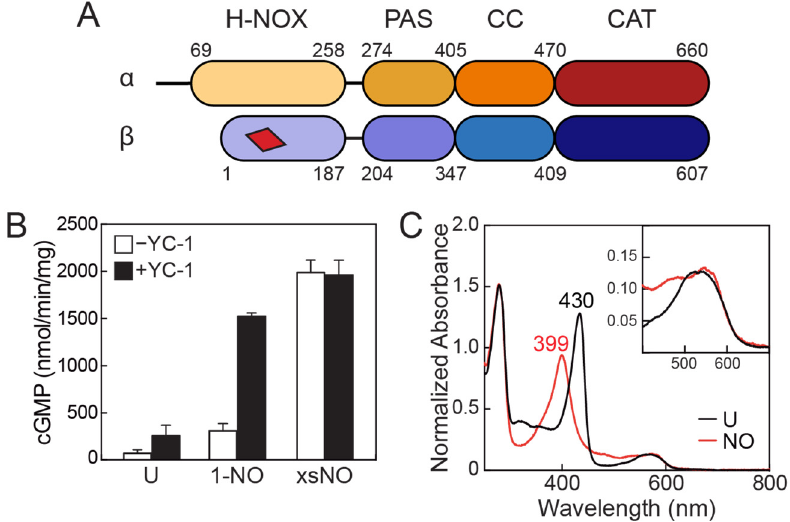
Figure 1. An introduction to sGC. ( A ) sGC domain architecture. sGC is a heterodimer composed of homologous α and β subunits. Each subunit contains four domains: an N-terminal heme NO/O 2 - binding (H-NOX) domain, a Per-Arnt-Sim (PAS) domain, a coiled coil (CC) domain, and a C-terminal catalytic (CAT) domain. The red trapezoid represents the heme cofactor found in the β H-NOX domain. Residue numbering of the domains corresponds to the sequence of human sGC. ( B ) Typical activity profile of sGC. sGC exhibits a low, basal level of activity in the absence of NO (U: unliganded). Addition of a single equivalent of NO (1-NO) results in a modest increase in activity. Full sGC activity is obtained in the presence of a molar excess of NO (xsNO). Activity can also be stimulated by the small molecule 3-(5 ′ -hydroxymethyl-2 ′ -furyl)-1-benzylindazole (YC-1). ( C ) UV-Visible absorption spectra of ligand binding to the sGC heme. Upon NO binding, the Soret peak shifts from ~430 to 399 nm. The inset shows the Q-band region of the spectra. Figure adapted from reference